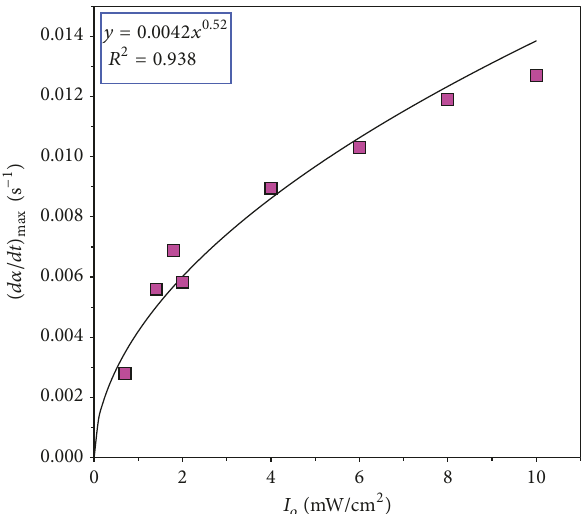
Figure 5: The reaction rates (𝑑𝛼/𝑑𝑡) as a function of light intensity ( 𝐼 𝑜 ). The solid line represents the fitted curve based on (3).